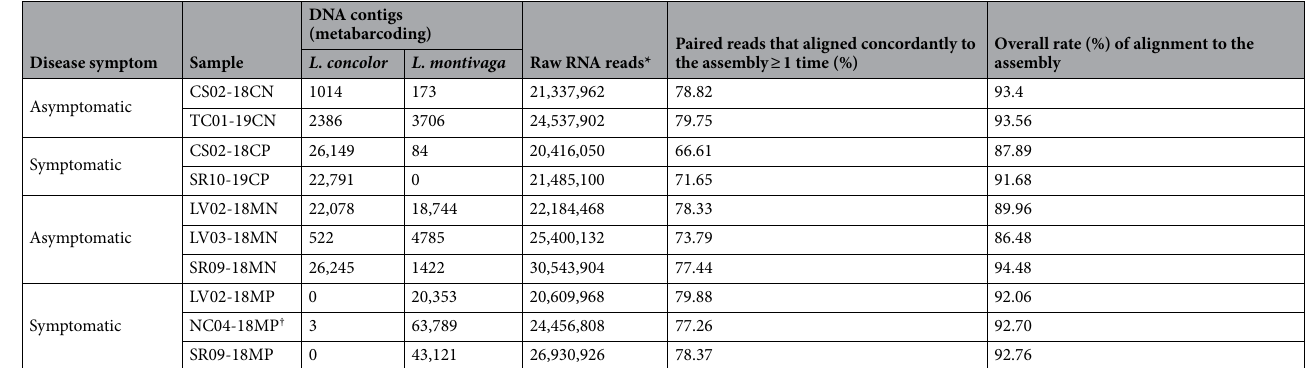
Table 2. Metabarcoding and metatranscriptome profile of Pinus contorta needle samples. Proportions (%) of raw reads that aligned to the metatranscriptome assembly and the overall alignment rate are also shown. Cross ( † ) represents samples excluded from the analyses. *Number of RNA reads per sample annotated as fungi through concatenated databases of NCBI-nr and JGI Mycocosm is listed on Table